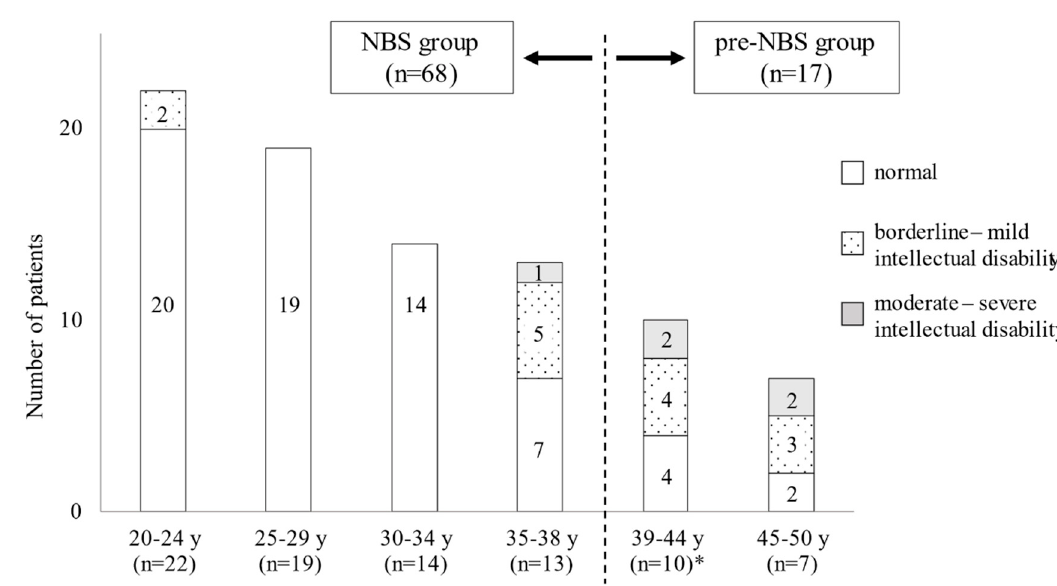
Figure 1. Degree of intellectual disability in patients stratified by age before and after newborn screening.*, A 37-year-old female was included in the “39–44-year-old subgroup” of the pre-newborn screening (NBS) group because she did not undergo NBS.